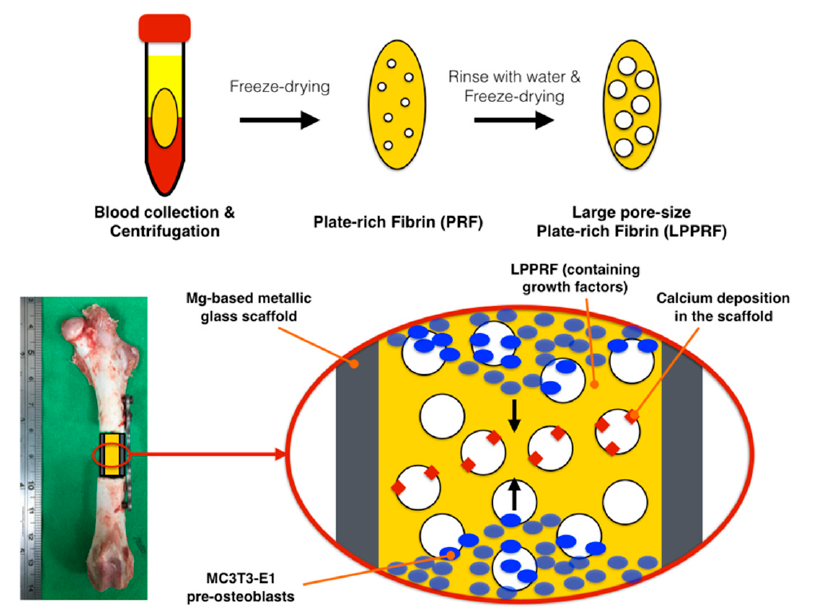
Figure 1. Large-pore platelet-rich fibrin and a magnesium scaffold improved cell migration and osteogenic differentiation for critical-size bone defect repair.